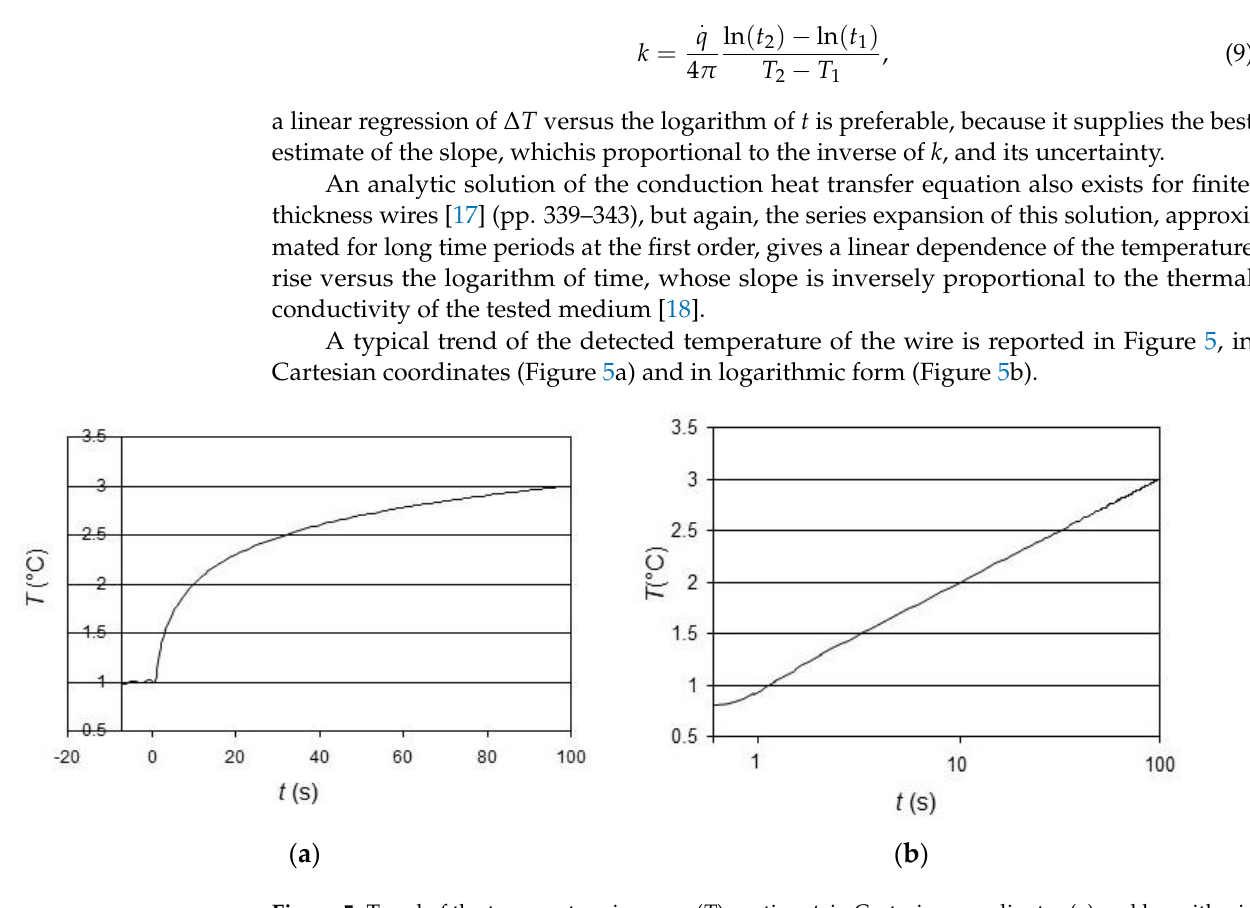
Figure 5. Trend of the temperature increase ( T ) vs. time t , in Cartesian coordinates ( a ) and logarithmic form ( b ).